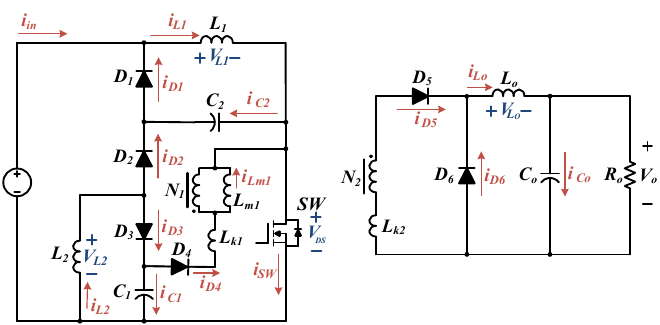
Figure 4. Definitions of voltage polarity and current direction of the proposed converter.